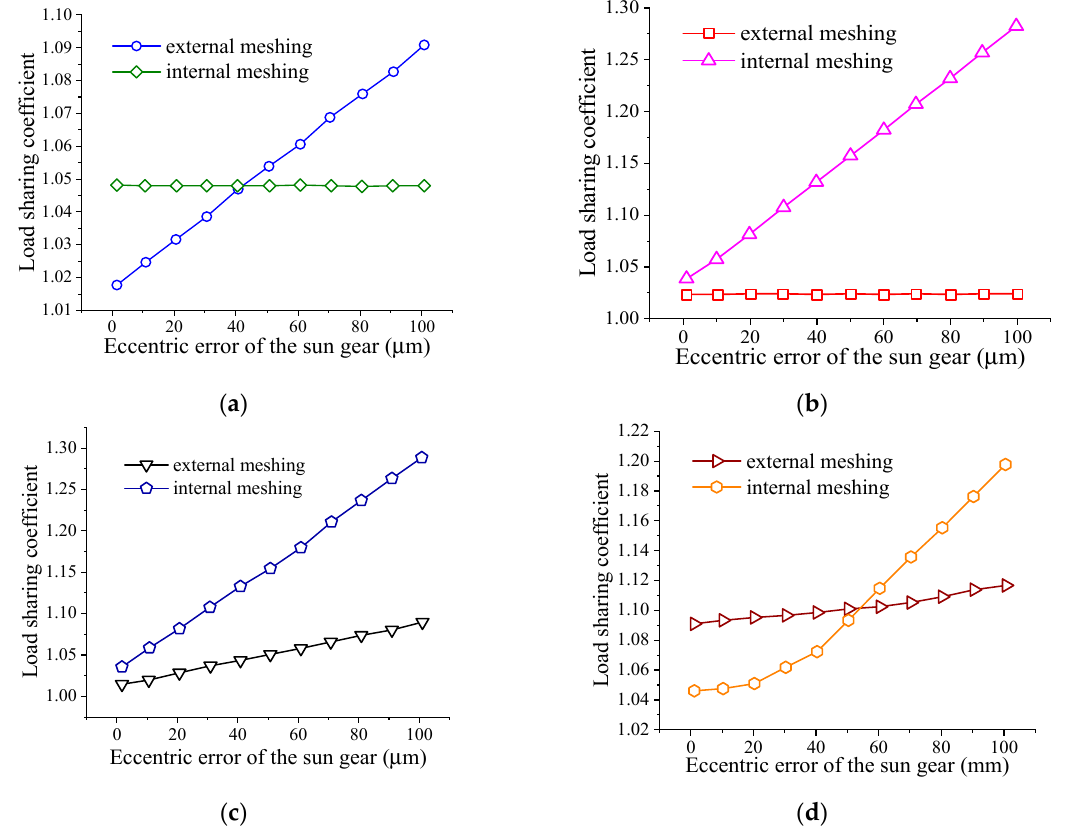
Figure 11. The effect of the eccentric error on the load sharing coefficient. ( a ) Eccentric error of the sun gear; ( b ) eccentric error of the ring gear; ( c ) eccentric error of the planetary gear; ( d ) eccentric error of the carrier.